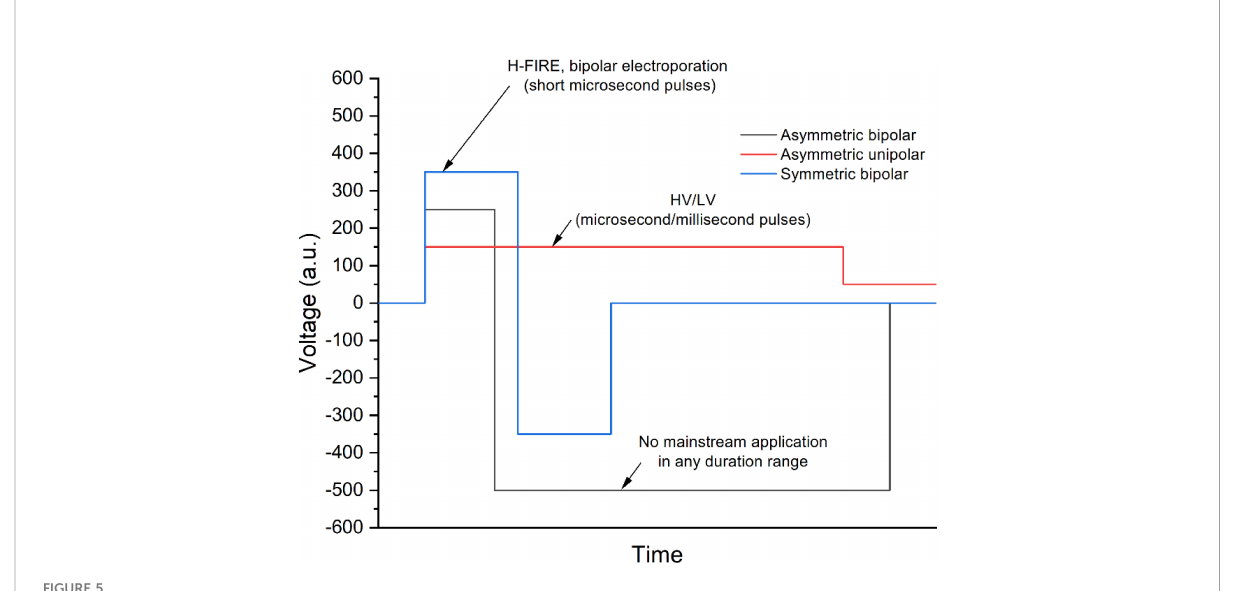
FIGURE 5 The examples of asymmetric and symmetric